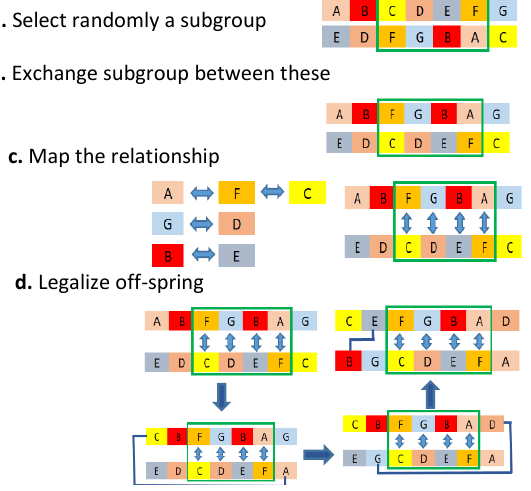
Fig 3. The Process of Partially mapped Crossover